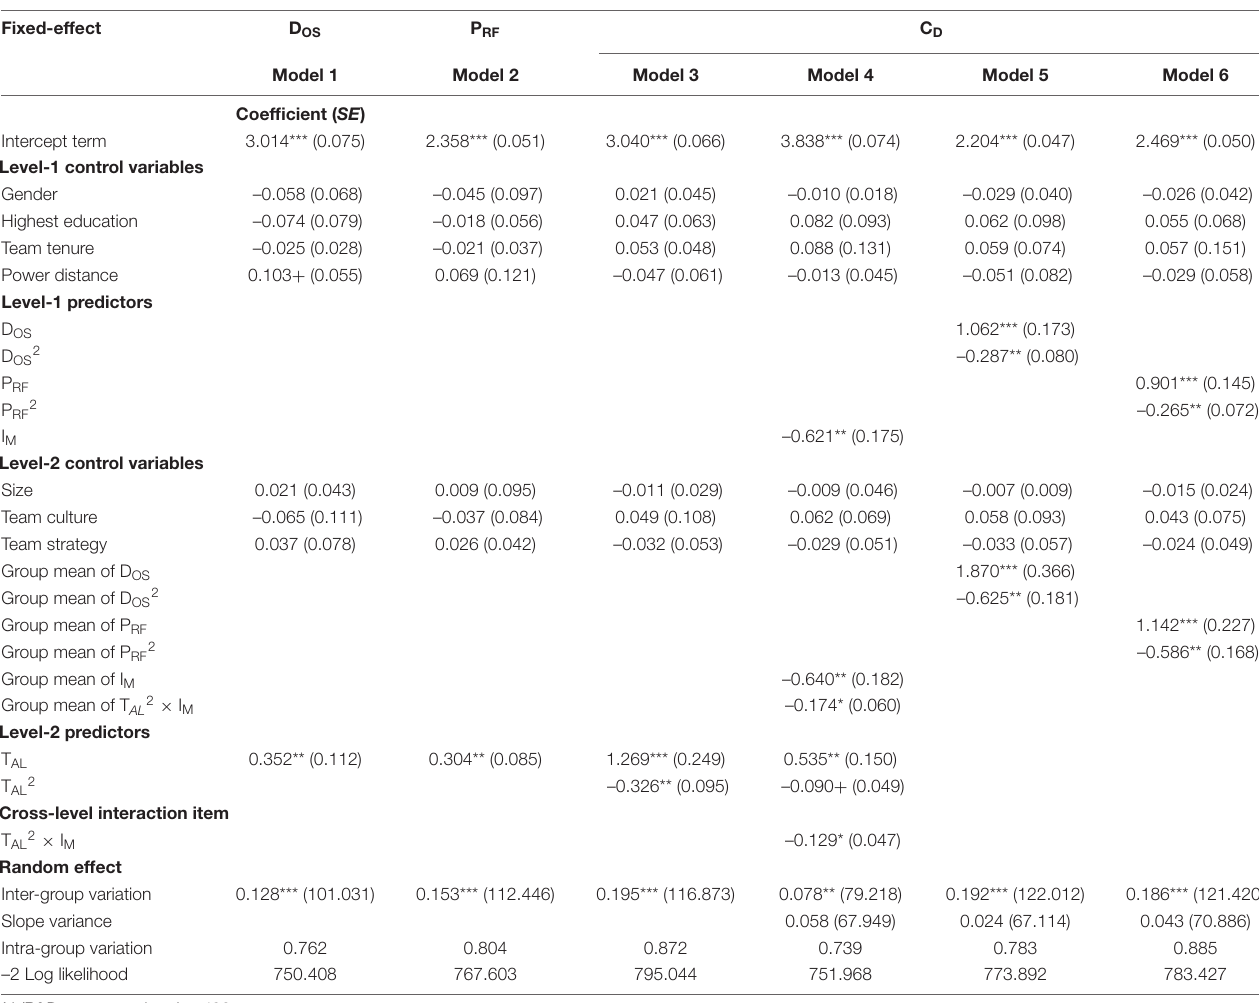
TABLE 5 | HLM analysis results.